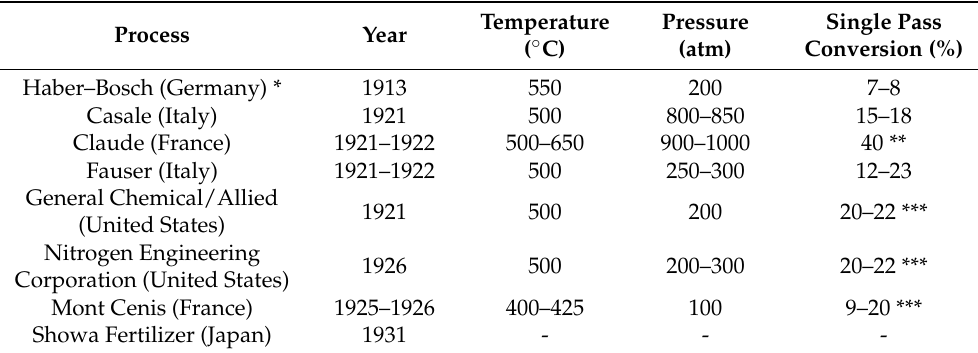
Table 1. Comparison of reported yields for synthetic ammonia technologies. Values adapted from references